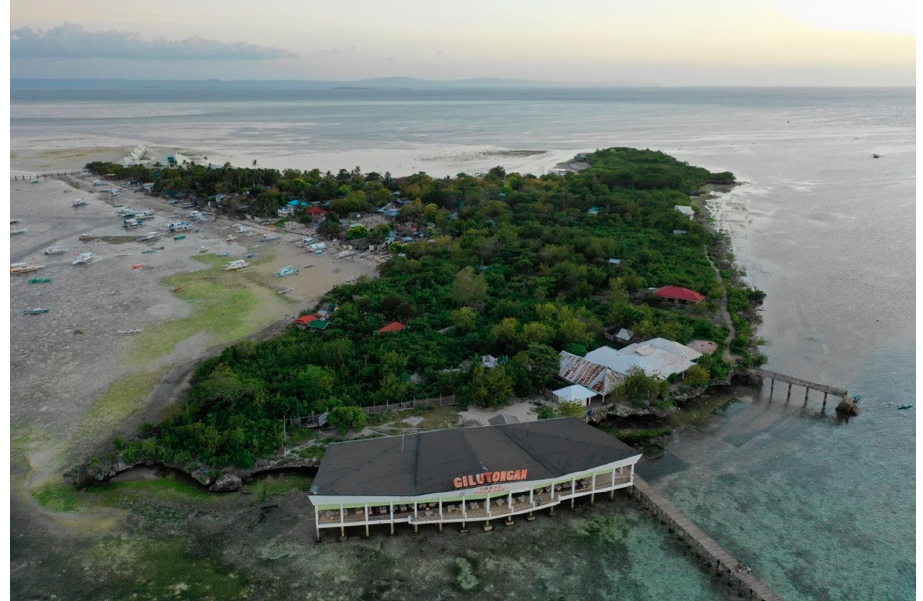
Figure 2. Gilutongan Island in Cordova, Cebu, Philippines.